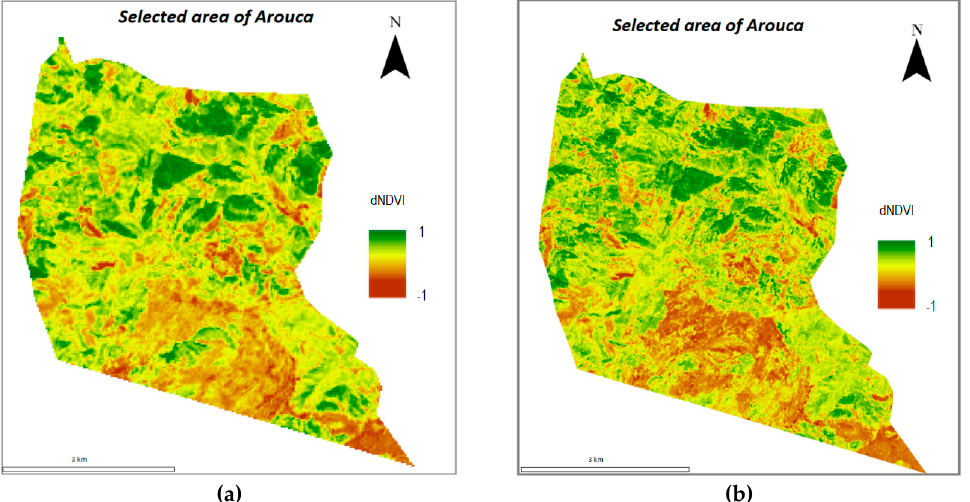
Figure 7. NDVI difference (dNDVI) maps for the selected area of Arouca for: ( a ) Landsat 8 and ( b ) Sentinel 2A.